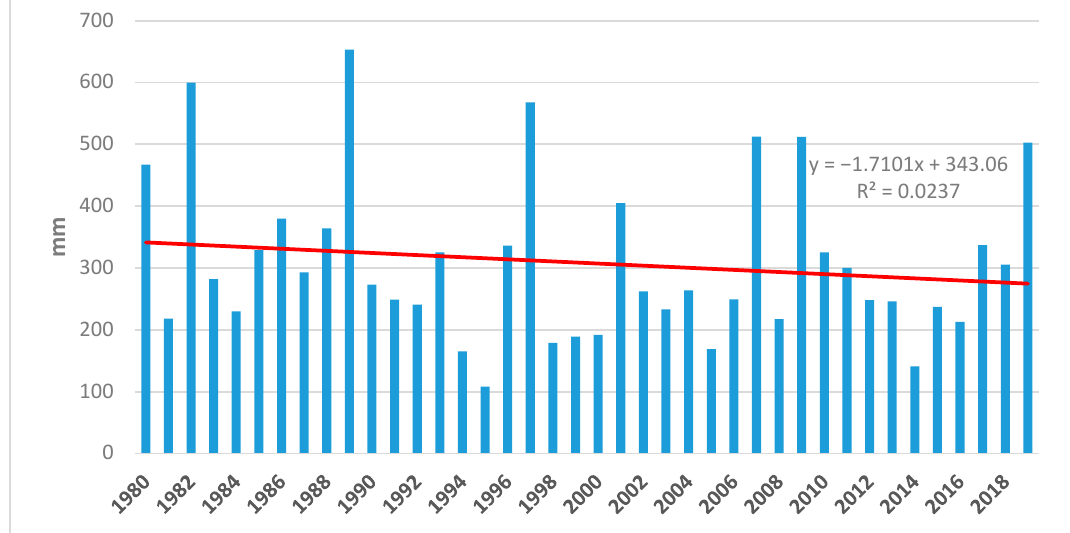
Figure 2. Evolution of the rainfall/year in the city of Alicante (1980–2019). Source: [40]. Own elaboration.